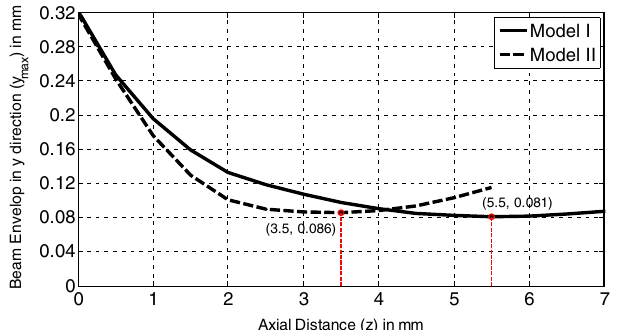
Figure 8. Compressions of beam envelops in y direction of the two models.